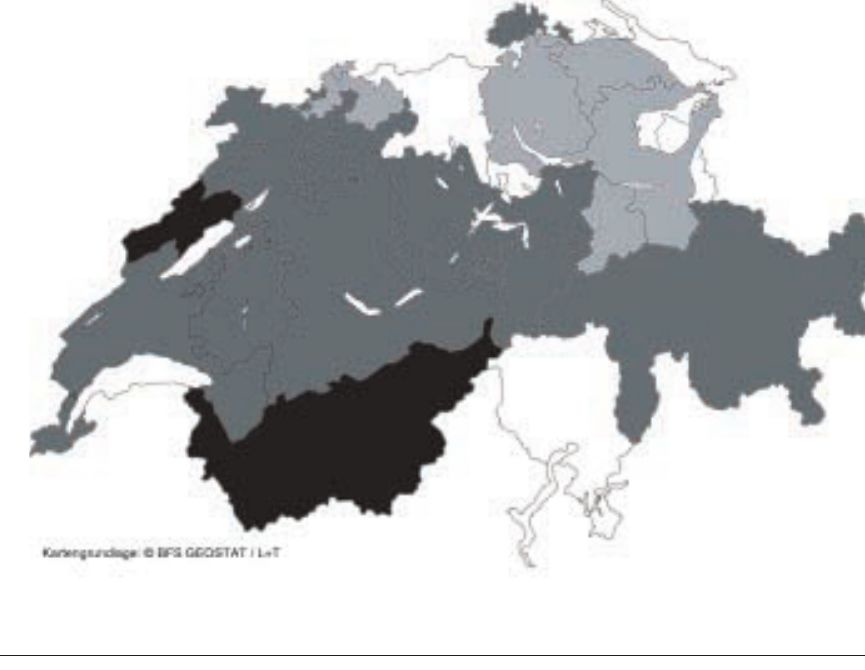
Estimated number of girls at risk